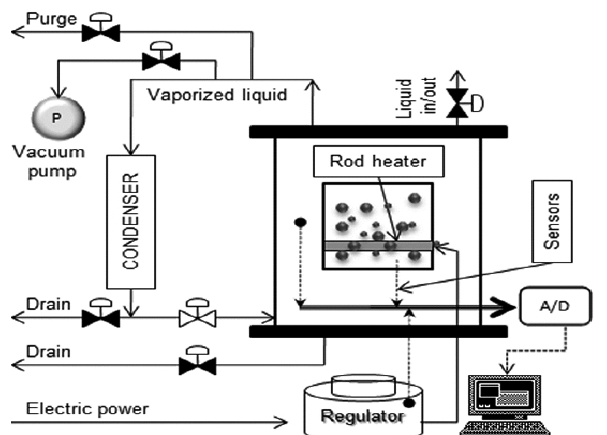
Fig. 1. Laboratory device details